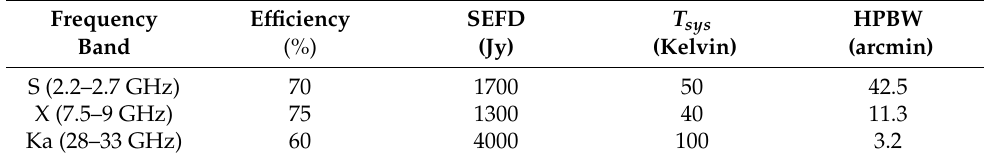
Table 6. Radio telescope performance